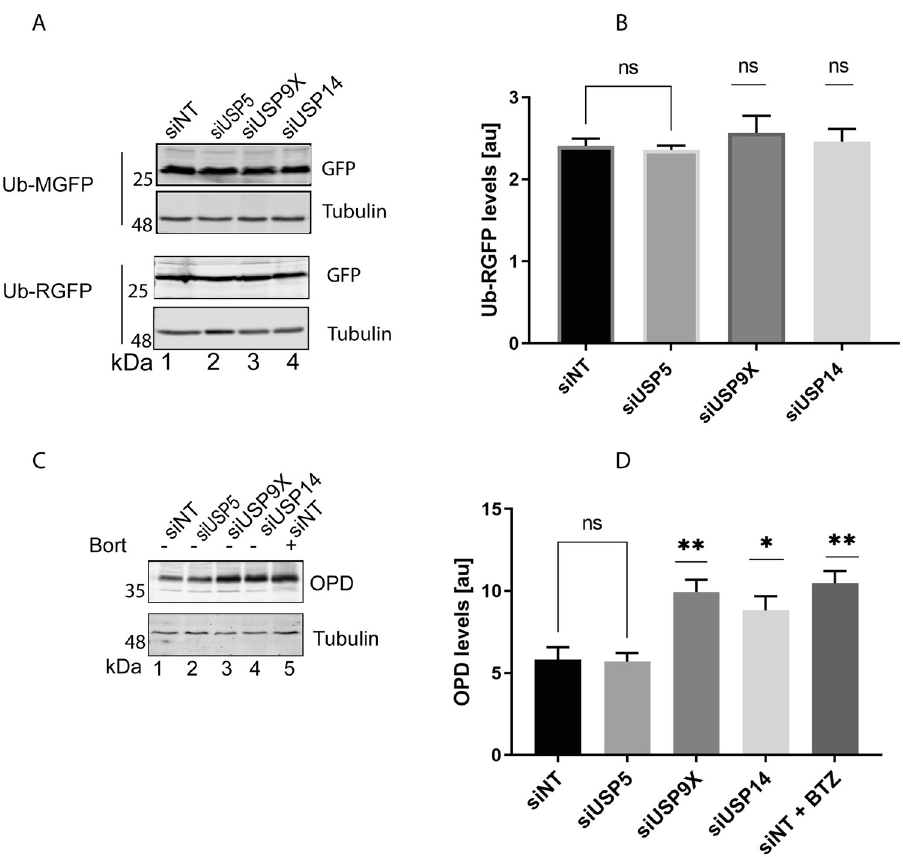
Fig 3. Loss of USP5 does not affect other substrates. A) HeLa M cells were seeded at 50% confluence and transfected with 1 nM of siRNAi targeting the indicated DUBs. Ub-MGFP and Ub-RGFP were transfected 48 h later and cells grown for 20 hrs post-transfection. Total cell lysates were prepared and analysed by Western blotting using GFP antibodies and tubulin (loading control). B) Ub-RGFP signals were quantified using the Odyssey 1 Fc imaging system and normalised to the tubulin loading control, values show standard errors for n = 3. Pairwise comparisons relative to the NT control, were performed using GraphPad Prism. Student t-test: P > 0.05 = ns, P � 0.05 = � , P � 0.01 = �� , P � 0.001 = ��� . C) HeLa TRex Flp-In cells stably expressing OpD after induction were seeded at 50% confluence and transfected with 1 nM of siRNAi targeting the indicated DUBs. OpD expression was induced 48 h later, and cells grown for 20 hrs post induction. Total cell lysates were prepared and analysed by Western blotting using opsin antibodies to detect OpD, and tubulin (loading control). D) OP91 signals were quantified using Odyssey 1 Fc imaging system and normalised to the tubulin loading control, values show standard errors for n = 3. Pairwise comparisons relative to the NT control, were performed using GraphPad Prism. Student t-test: P > 0.05 = ns, P � 0.05 = � , P � 0.01 = �� , P � 0.001 = ��� and P � 0.0001 = ����